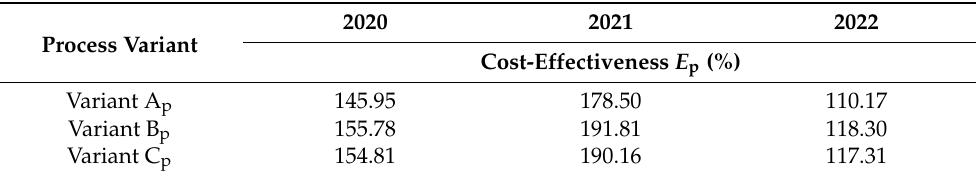
Table 18. List of efficiency indicators E p for producing semi-finished furniture elements in